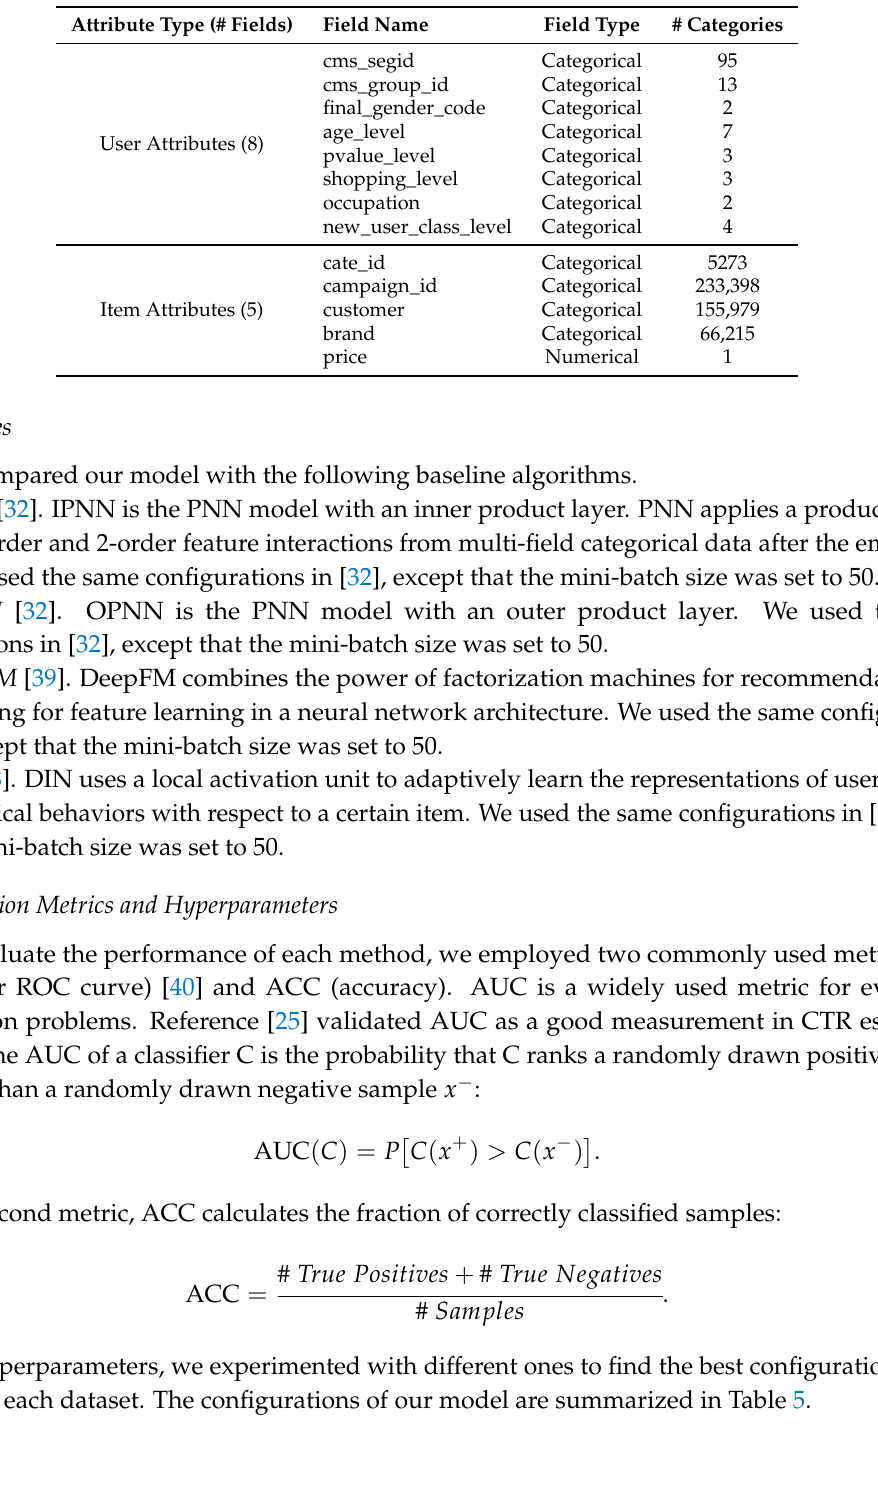
Table 4. Attribute statistics for the Taobao